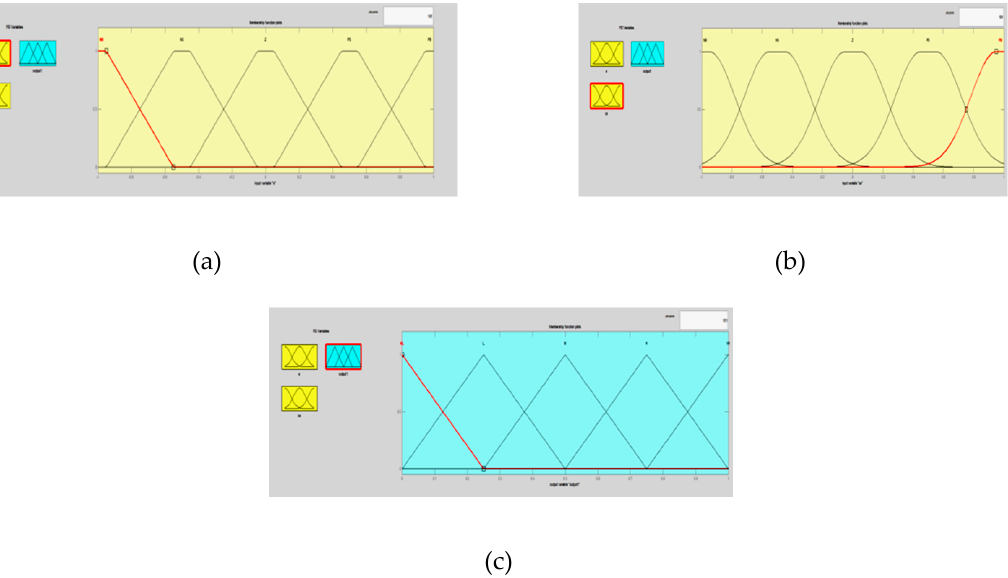
Figure 17. Membership Functions for Rule 2: ( a ) Input 1(error); ( b ) input 2 (change in error); ( c ) output. The overall rule viewer is shown in Figure 18.